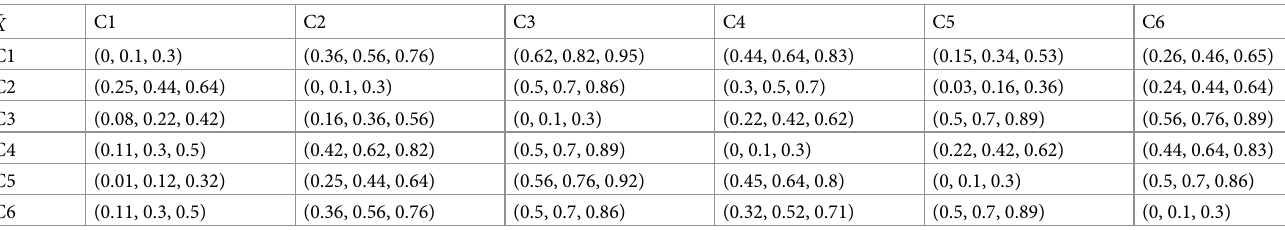
Table 5. Computing the matrix of fuzzy direct